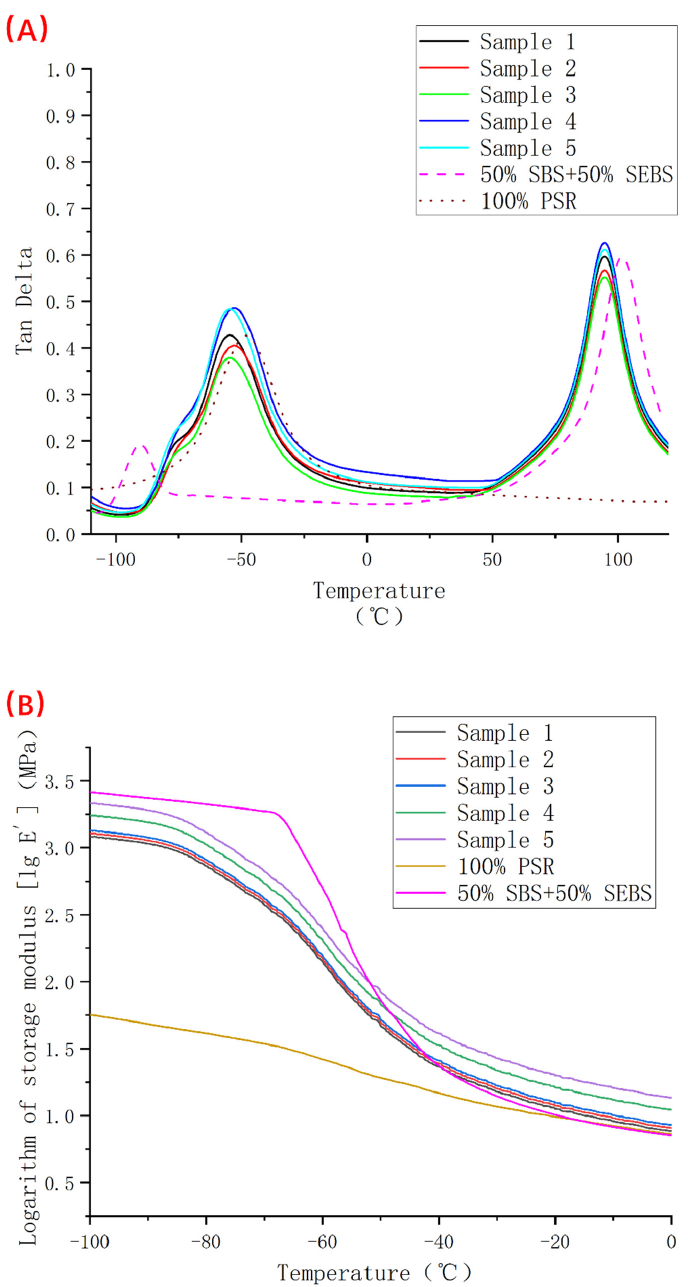
Figure 10. Dynamic mechanical test results of samples 1–5 (where ( A ) is the tangent value curve of loss angle from − 110 °C to 120 °C and ( B ) is the logarithm of the storage modulus from − 100 °C to 0 °C).